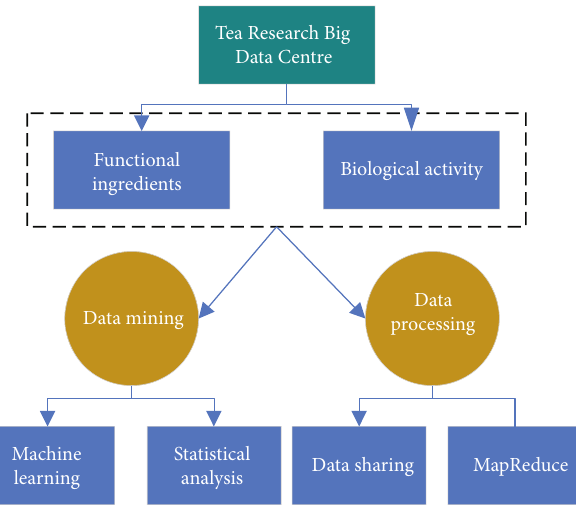
Figure 3: Visual comparison of the results of the four tea